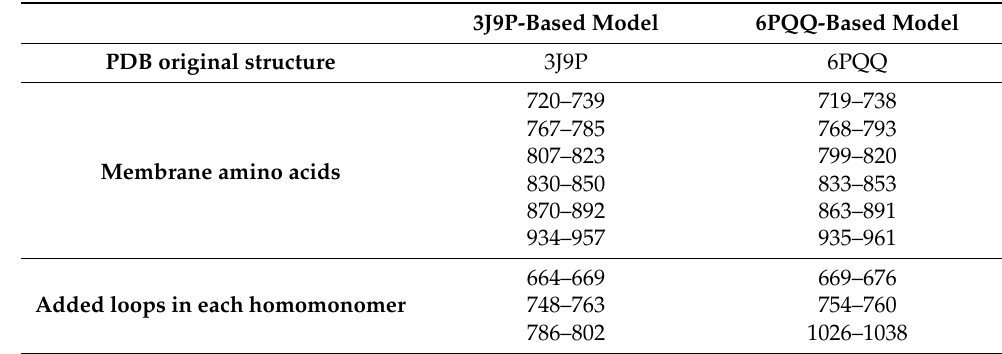
Table 7. The prepared models of the TRPA1 ion channel: original structures, amino acids in the cell membrane, and added loops in the process of homology